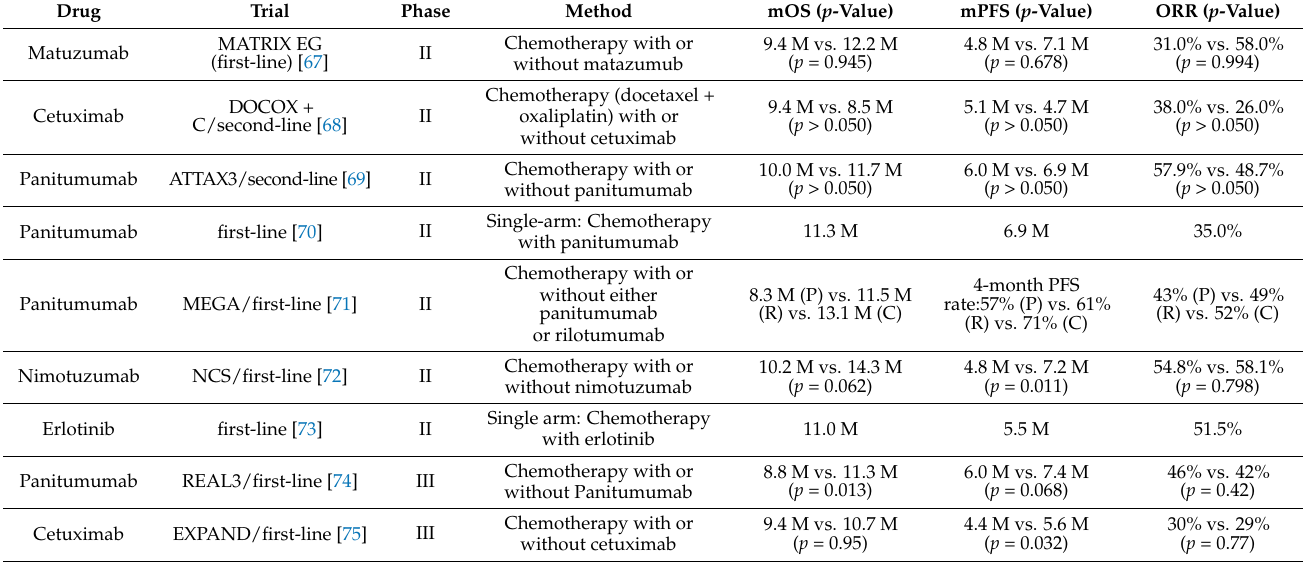
Table 1. Phase II and III trials of therapies targeting human epidermal receptor-1 (HER-1). mOS, median overall survival; mPFS, median progression-free survival; ORR, objective response rate; M,